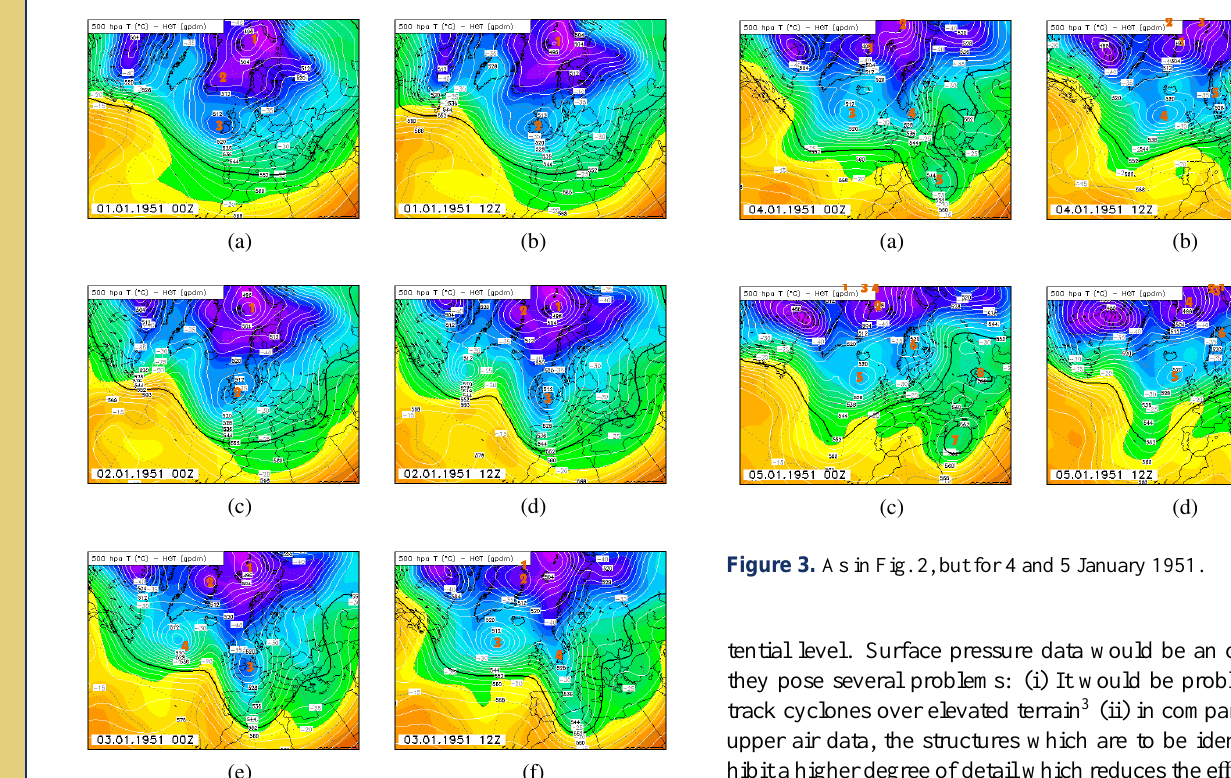
Adv. Sci. Res. www.adv-sci-res.net